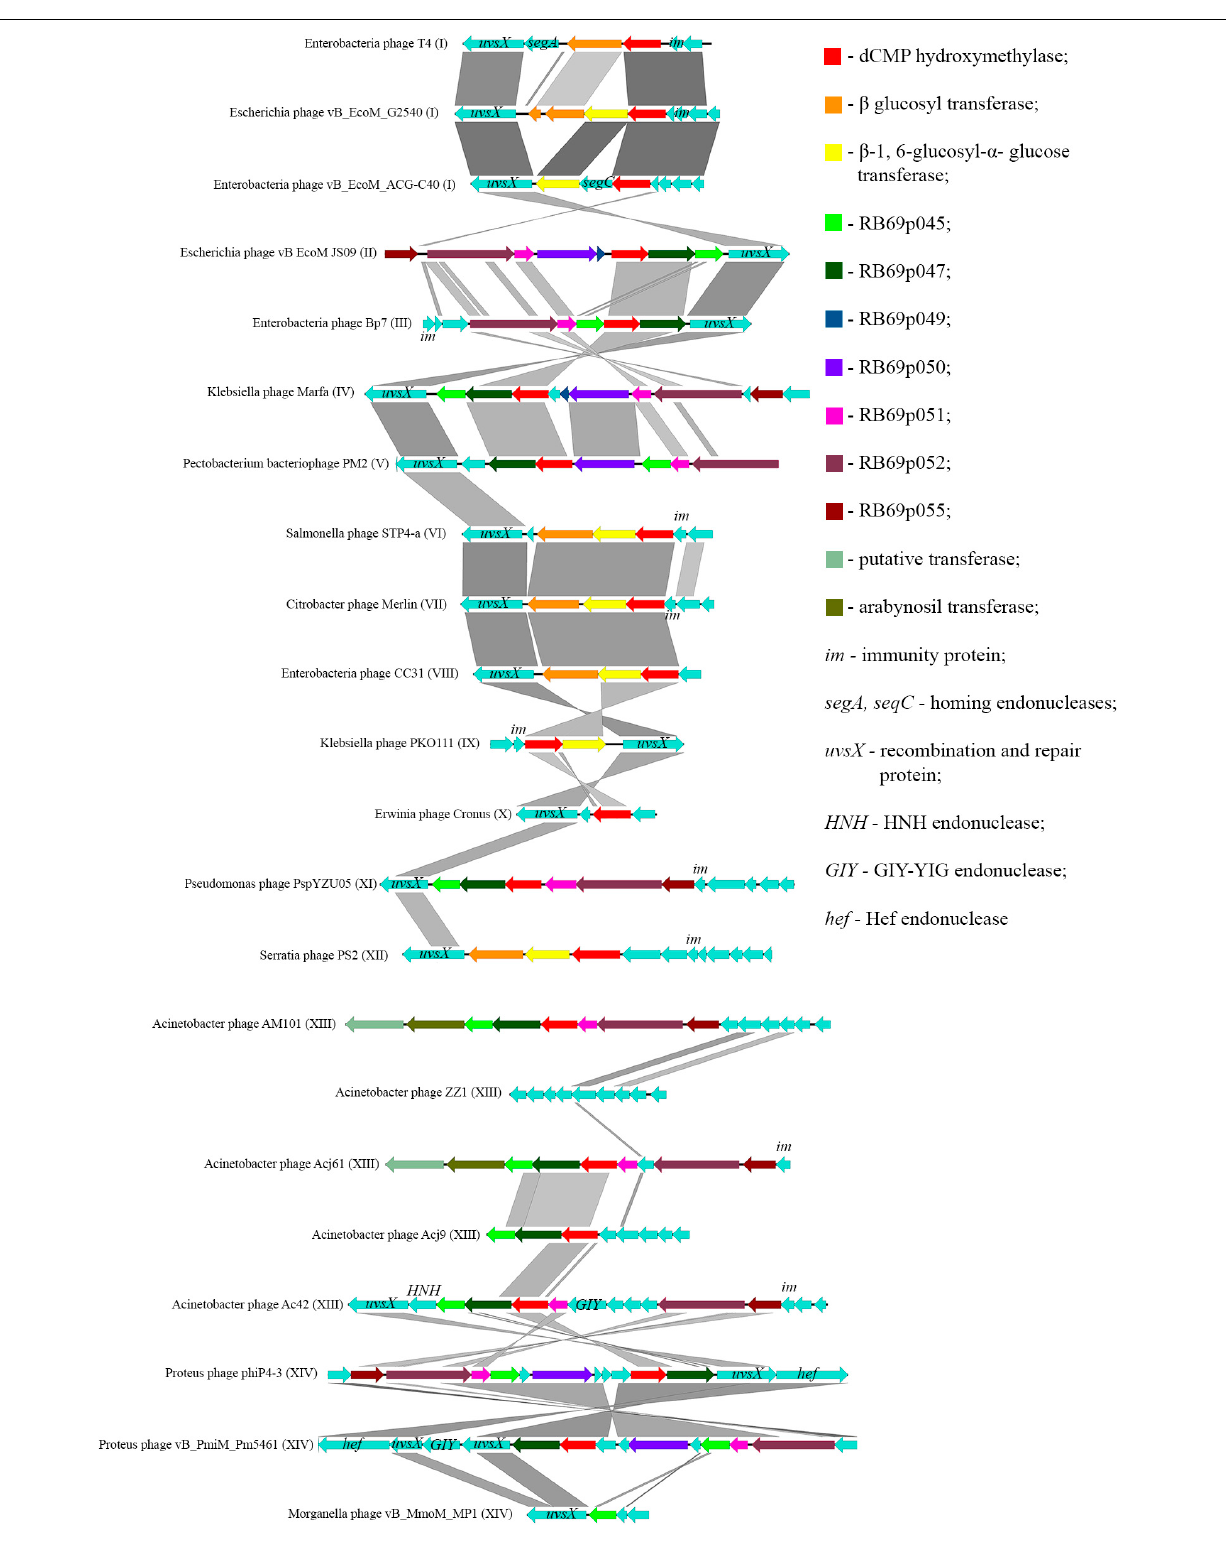
FIGURE 6 | Variations in the region between the genes homologous to the genes of DNA polymerase and head vertex assembly chaperone in closely related Tevenvirinae that have homologs of hm dC-associated proteins. The genes whose products are described in Table 2 are indicated by color; the genes whose products have homologs with known functions are additionally